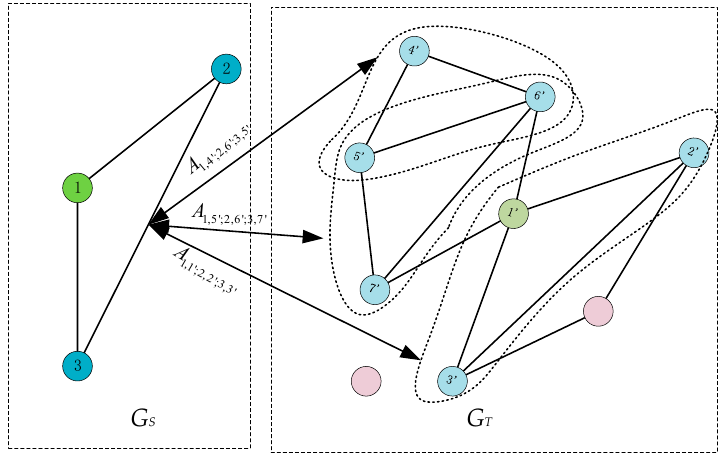
Figure 6. ANN searching for triangles.